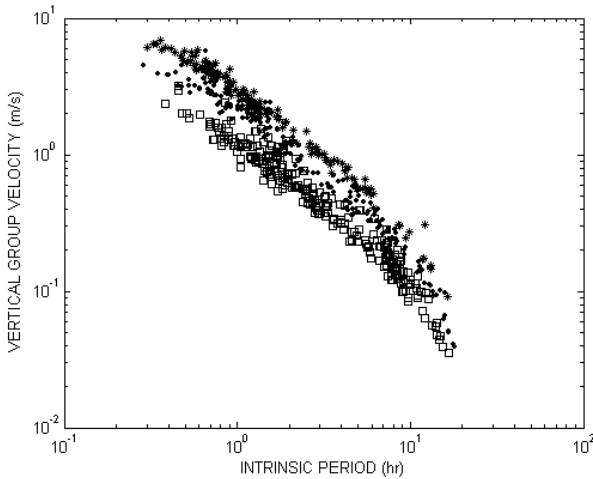
Fig.12 Vertical group velocities versus intrinsic periods of upward moving gravity Fig. 12. Vertical group velocities versus intrinsic periods of upward wave packets of winter data set. Wave packets obtained by window T2Z3, moving gravity wave packets of winter data set. Wave packets ob- T3aZ3, T3bZ3, T3cZ3 and T4Z3 were denoted by ‘square’ ; Wave packets tained by window T2Z3, T3aZ3, T3bZ3, T3cZ3 and T4Z3 were de- obtained by window T2Z4, T3aZ4, T3bZ4, T3cZ4 and T4Z4 were denoted by noted by square; Wave packets obtained by window T2Z4, T3aZ4, ‘dot’ ; Wave packets obtained by window T2Z5, T3aZ5, T3bZ5, T3cZ5 and T3bZ4, T3cZ4 and T4Z4 were denoted by dot; Wave packets ob- T4Z5 were denoted by ‘star’ tained by window T2Z5, T3aZ5, T3bZ5, T3cZ5 and T4Z5 were denoted by